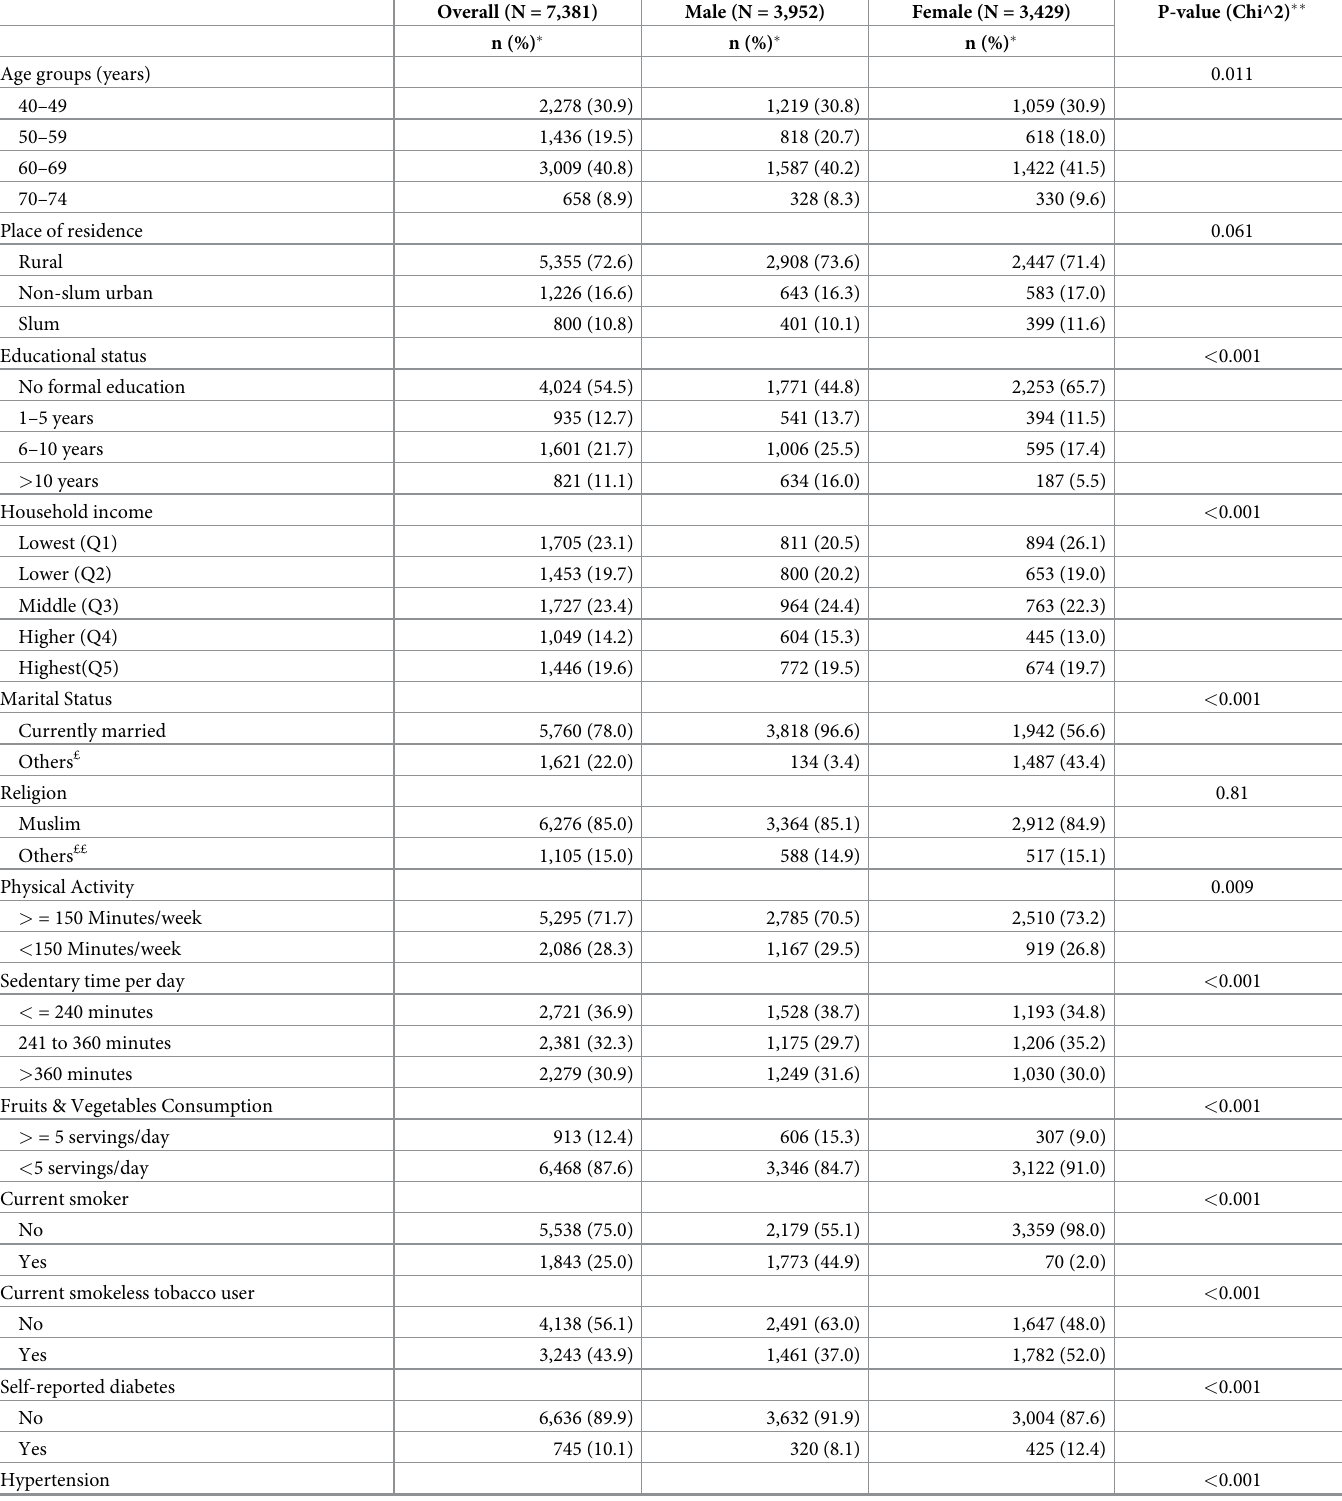
Table 1. Sociodemographic, behavioral and biological characteristics of the study participants by